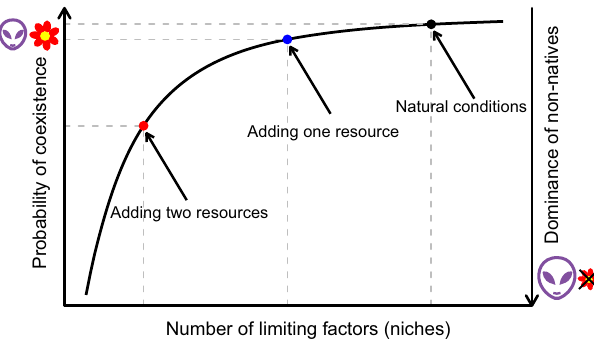
Fig. 1 Graphical illustration of the potential effect of the number of limiting factors on species coexistence. The probability of species coexistence increases with the number of limiting factors (according to the niche-dimension hypothesis), asymptotically approaching a 100% chance of coexistence. This is because the higher the number of limiting factors, the more likely that different species are constrained by different limiting factors. Under natural conditions (black dot), there are multiple limiting factors, such as nutrients, light, and enemies, favoring species coexistence. Adding one resource type will reduce the dimensionality of the niche space (i.e. number of limiting factors), thereby slightly reducing the probability of coexistence (blue dot). Adding multiple resource types will reduce the niche dimensionality, even more, greatly reducing the probability of coexistence and favoring the dominance of a single species (red dot). Because non-native species are likely to be pre-adapted to high resource availability and/or to be limited by fewer factors, their dominance is expected to be favored by the addition of multiple resource